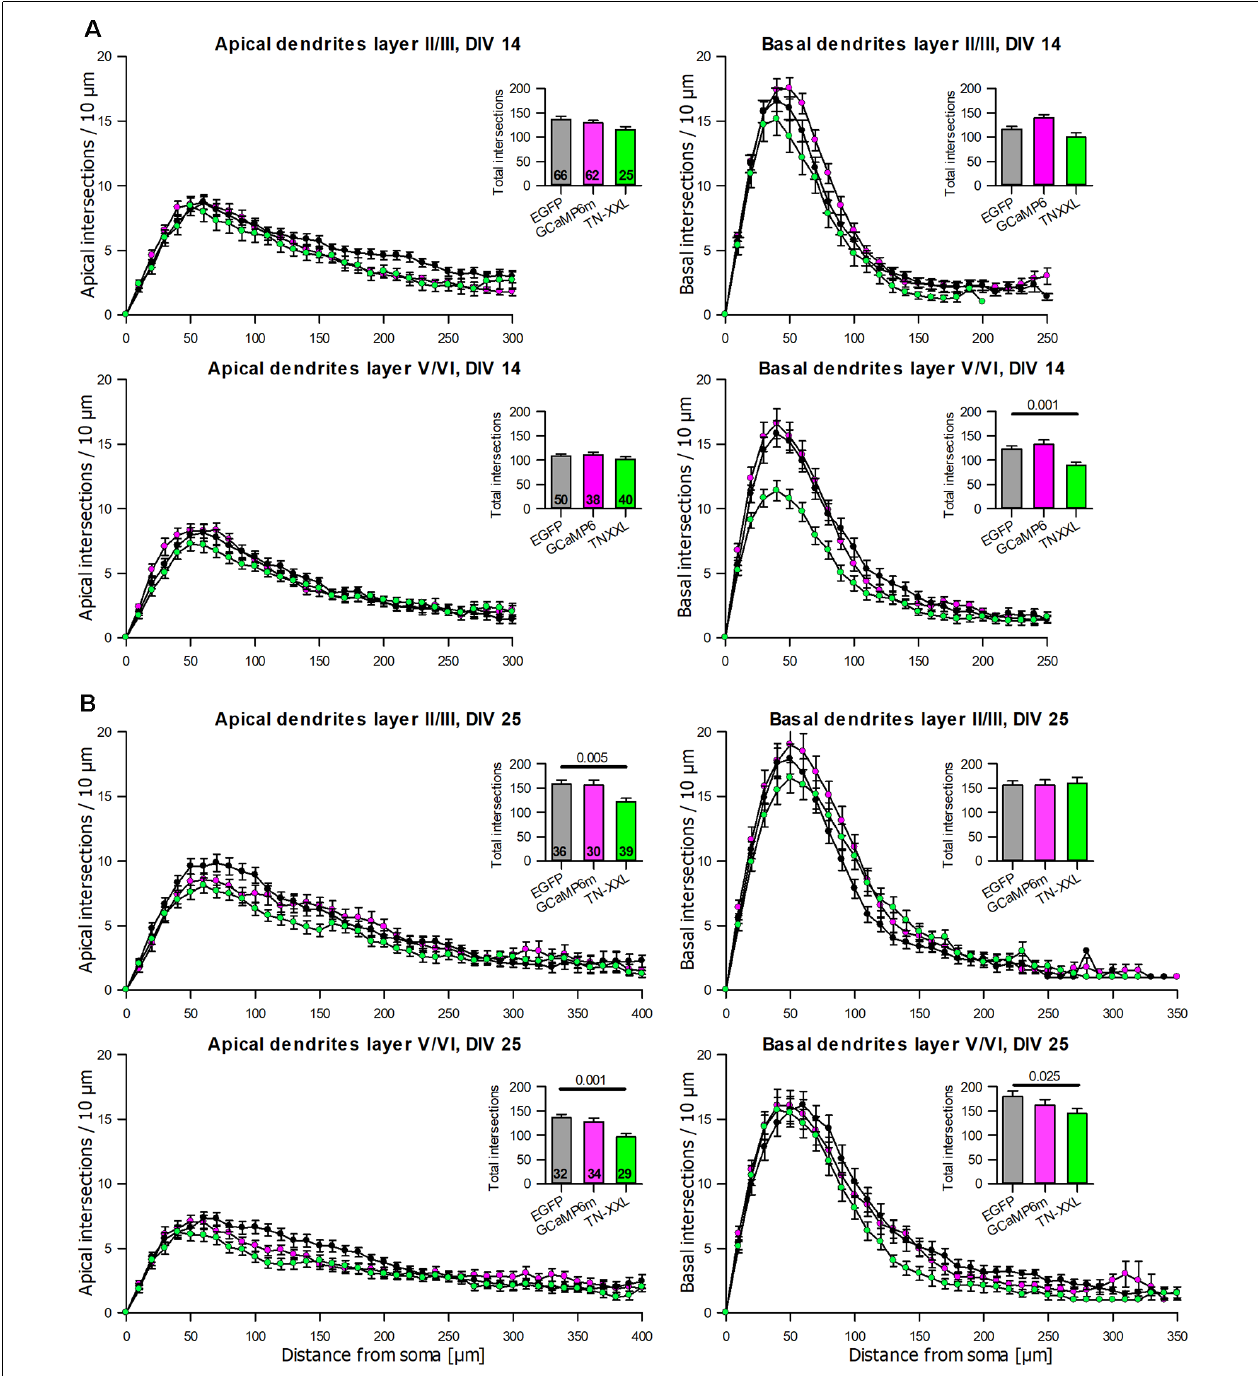
FIGURE 6 | Sholl analyses of apical and basal dendrites of pyramidal neurons of layers II/III and V/VI expressing GCaMP6m and TN-XXL, respectively, vs. batch-internal EGFP expressing neurons. (A) DIV 14. (B) DIV 25. Insets report total intersections. P values of the Mann–Whitney rank-sum test vs. control performed after the ANOVA on ranks indicated a significant difference vs.